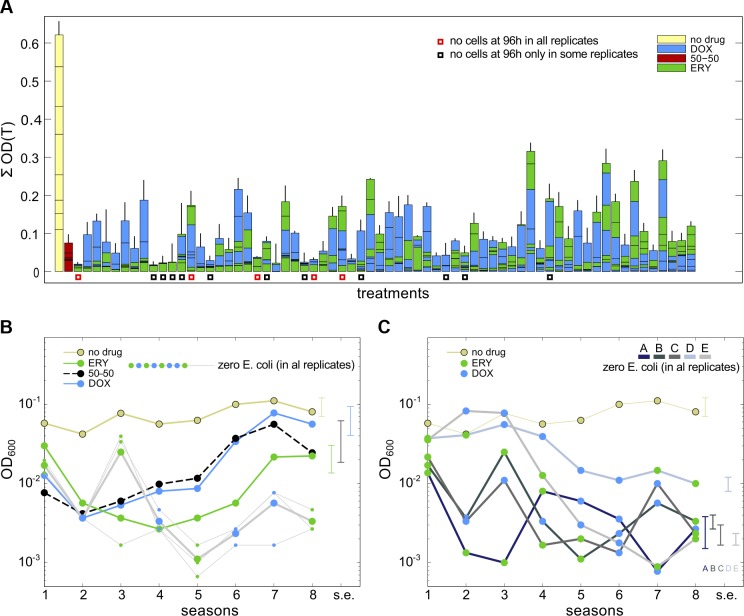
Some examples of successful sequential treatments at IC70 dosages.(A) This Manhattan plot at IC
70 shows the mean total optical densities observed during eight seasons of treatment (Σ0D(T) on the vertical axis, vertical lines are SE, and n = 3). Note the 16 treatments marked with a red or black square: they had among the lowest final densities of the treatments trialled. After this, the 16 treatments were replicated; a red square shows that a zero cell density was observed in all three initial and subsequent replicates of that treatment, and black squares show a zero population density was observed in some, but not all, replicates. (B) The no-drug, ERY, and DOX monotherapies and the 50/50 combination treatment all produce recovering mean population densities at IC70 doses. These four unsuccessful treatments are shown next to the optical density dynamics of three replicates of a successful “red square” treatment from (A) (treatment C in panel C). The three replicates (shown as grey lines with blue [DOX] and green [ERY] circles) indicate parallel dynamics and fluctuating decay towards zero (bars are SE of optical density at 96 h, n = 3). (C) Season-by-season mean densities of all the successful (red square) treatments from (A); note how two achieve high densities early during treatment. Fig S15 in S1 Text, section 3, shows colony-forming units for replicates of these treatments. (S1 Data contains the data used in this figure.)